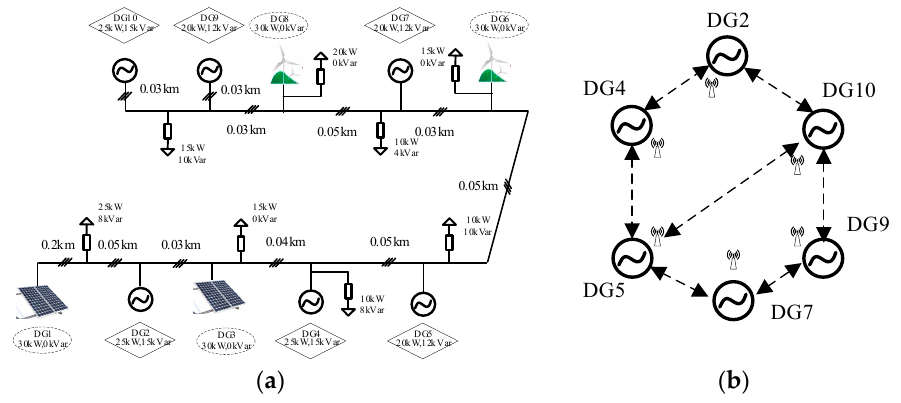
Figure 14. Modified microgrid test system: ( a ) Electrical network; ( b ) Communication topology.